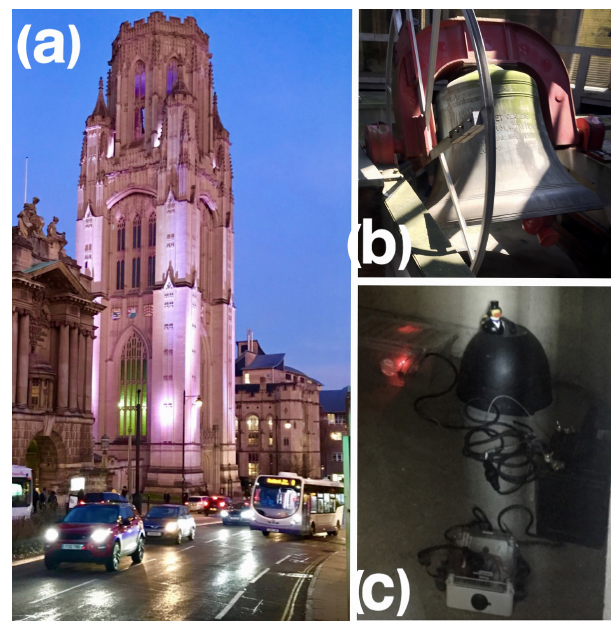
Figure 1. Great George bell (b) sits within the belfry of the Wills Memorial Building pictured in panel (a) on a typical weeknight. The broadband seismometer (c) installation set up in one of the alcoves above the bell. The instrument itself lies beneath the black dome with the Brunel rubber duck (geophysics group mascot) on